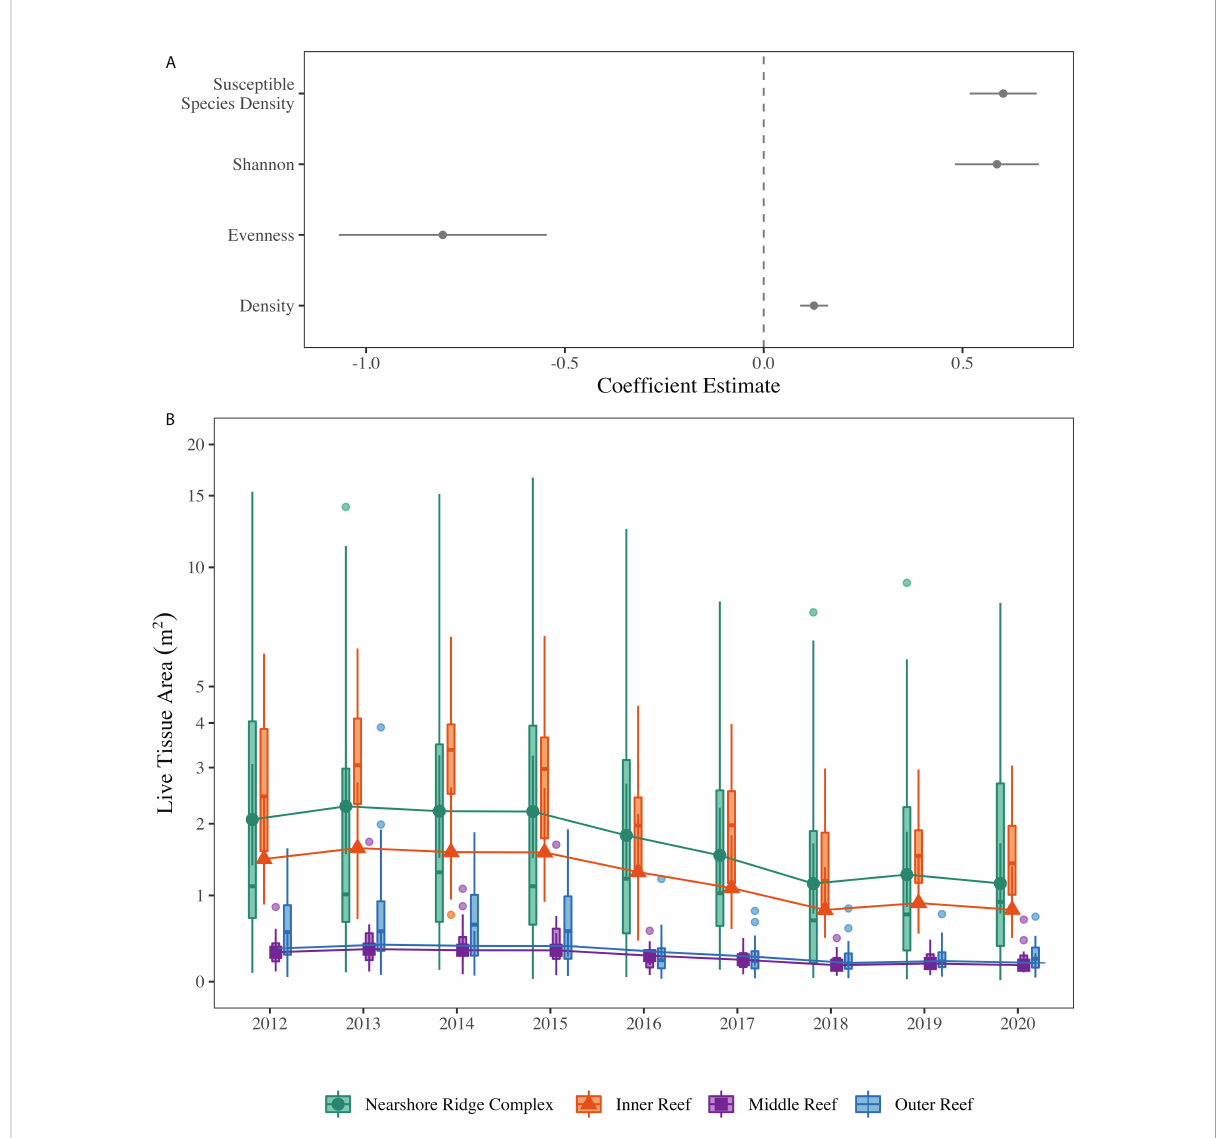
FIGURE 3 (A) Coef fi cient estimates (± SE) for the continuous predictors in the minimum adequate generalized linear mixed effects model (GLMM) testing the association of ecological parameters and stony coral live tissue area (LTA). Error bars that do not intersect zero are signi fi cant. Points > 0 indicate a positive relationship between the variable and LTA, whereas points < 0 indicate a negative association between the variable and LTA. (B) Results of fi xed categorical predictors (year, habitat) in the tweedie GLMM testing the spatiotemporal associations with LTA. The solid shapes indicate the means with the solid lines indicating the 95% within habitat con fi dence interval. The boxplots represent the raw data, with the solid line indicating the median and the upper and lower ends of the box representing the upper and lower quartiles, respectively. The whiskers extend from the upper or lower quartile to the maximum and minimum values and the dots represent possible outliers. Note the pseudo-log scale on the y-axis to allow visualization of the middle and outer reef